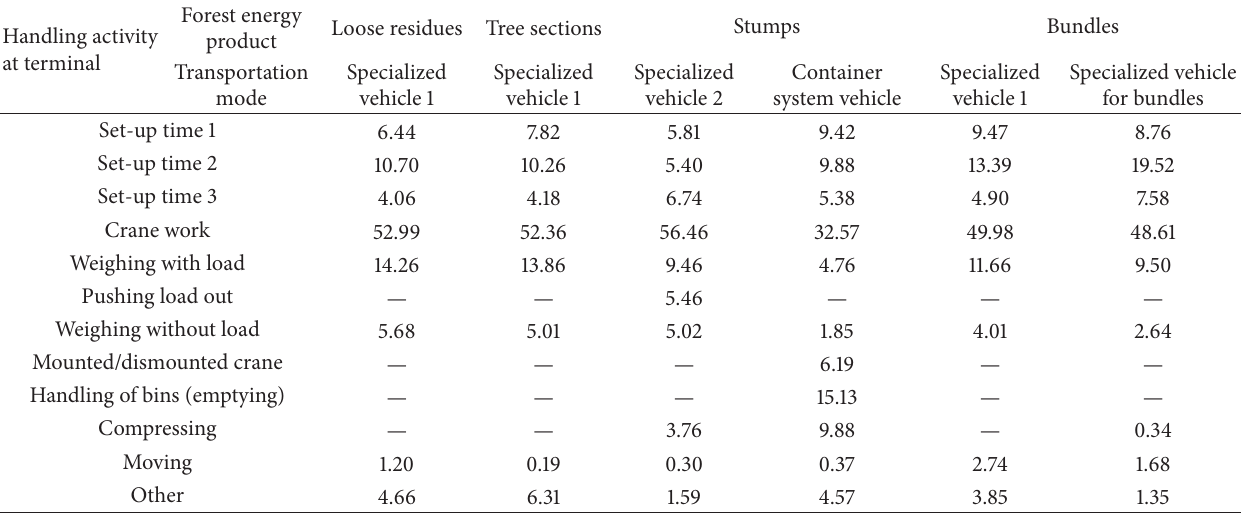
Table 2: Mean time consumption for specific handling activities in percentages.